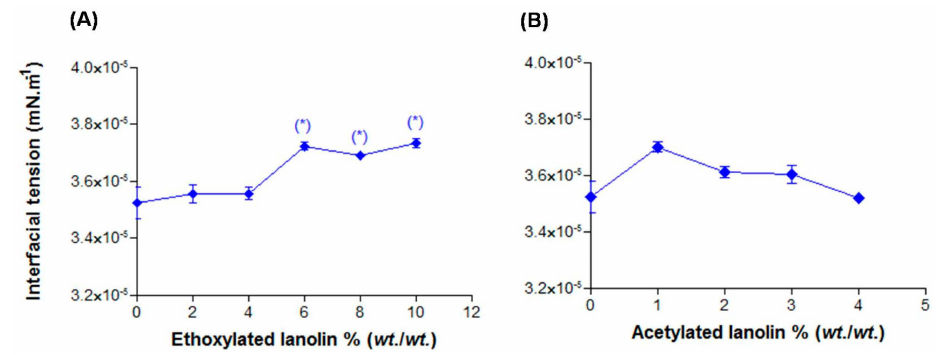
Figure 2. Interfacial tension in function of the lanolin derivatives: ( A ) EL and ( B ) AL. * p > 0.05.